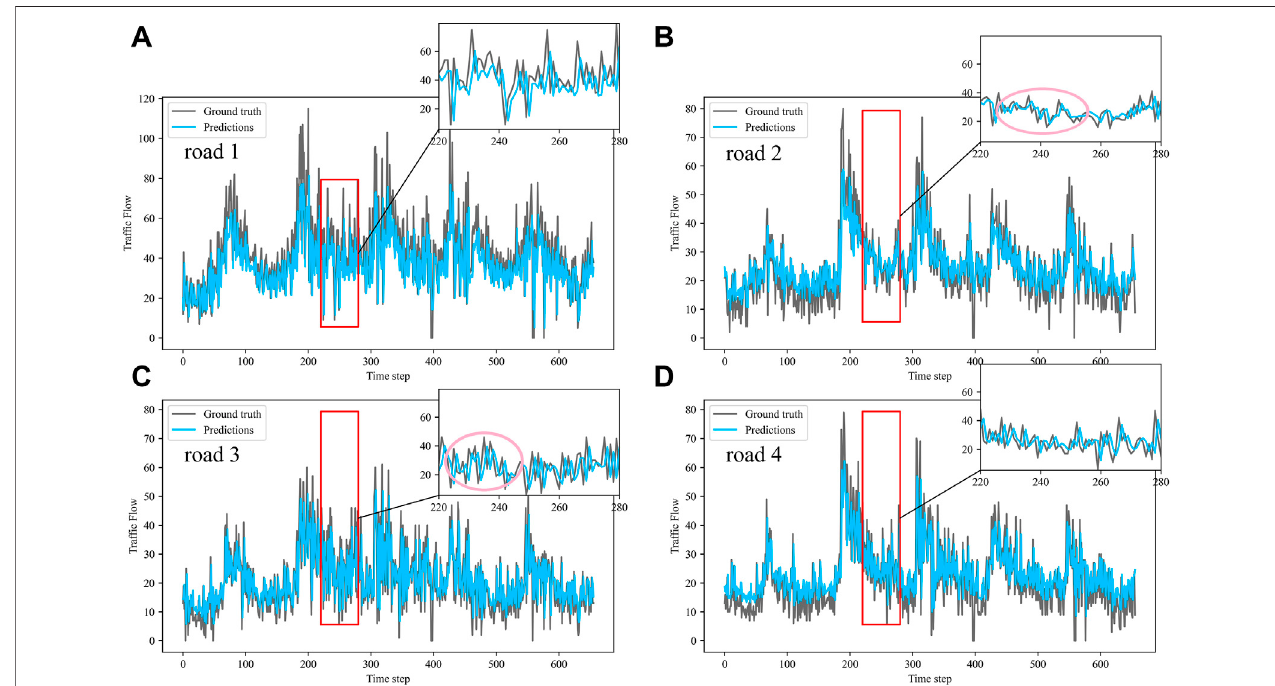
FIGURE 10 | Visualization of IMgruGcn model prediction results on off-peak dataset. (A) road 1 means Gudun Road. (B) road 2 means Fengtan Road. (C) road 3 means Yile Road. (D) road 4 means Jingzhou Road.